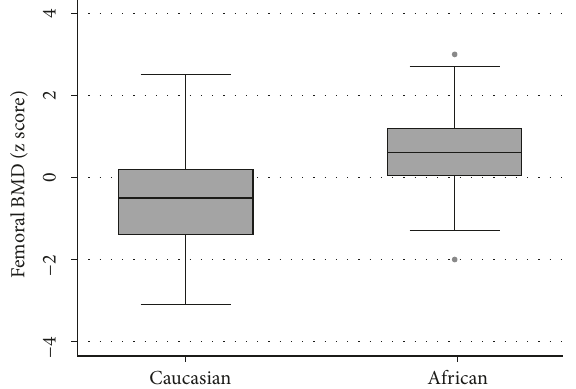
Figure 2: Box and whisker plot to investigate the relationship between femoral BMD z-score and